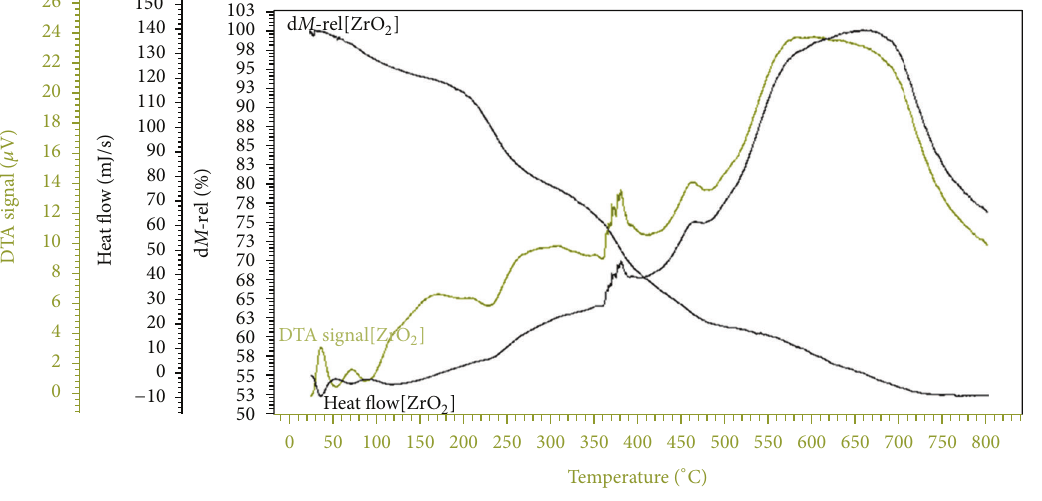
Figure 1: Thermal analysis (DTA-TGA) diagram for YSZ powder first dried at 80 ∘ C for 3hrs in an